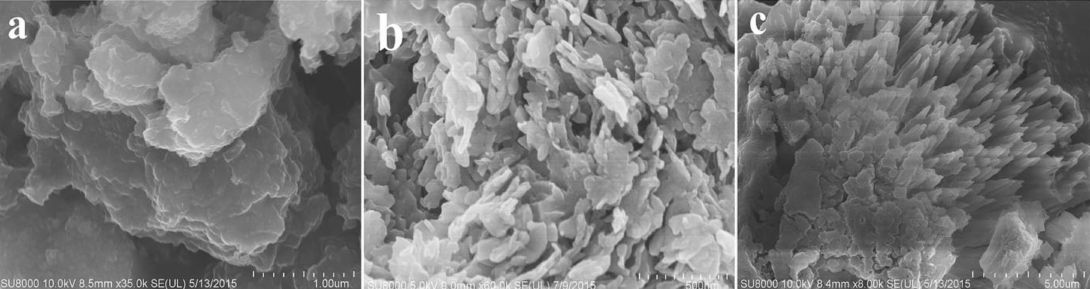
Figure 21. The FESEM micrograph of ( a ) pristine GCN, ( b ) S, Co-GCN, and ( c ) S, Co, O-GCN. Reproduced with permission from Ref.